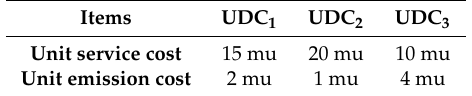
Table 5. The unit service cost and unit emission cost for each UDC. mu, monetary unit.